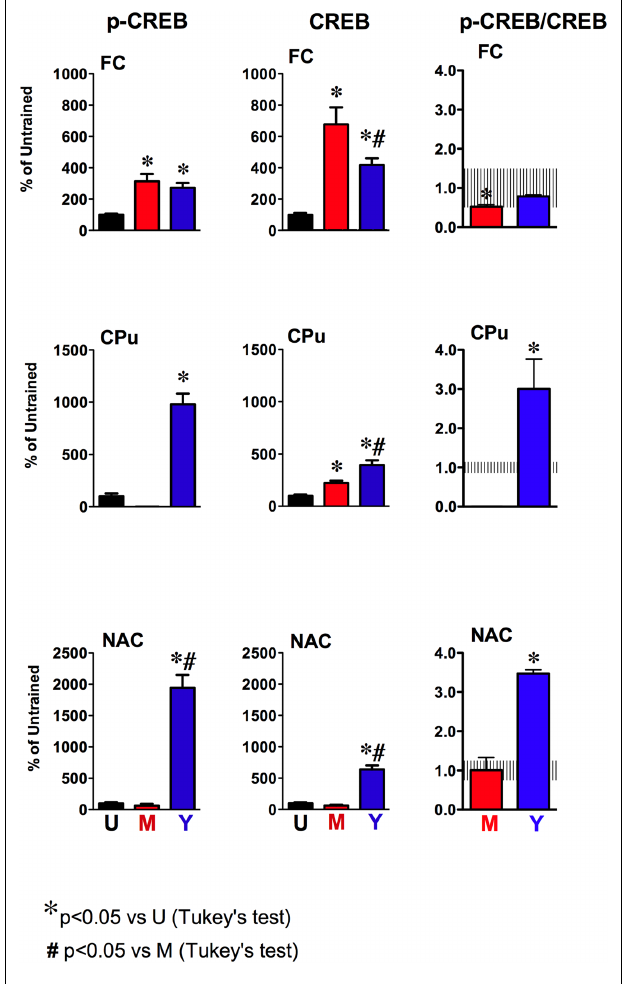
FIGURE 4 | Quantification of p-CREB and CREB levels and p-CREB/CREB ratios in the frontal cortex (FC) Caudate–putamen (CPu) and nucleus accumbens (NAC) of untrained (U), master (M), and yoked (Y) rats. Data are expressed as the percentage of protein level in untrained control rats. Histograms represent mean ± SEM of six to seven rats per group.The shaded areas represent the mean ± SD of p-CREB/CREB ratios for untrained control rats. * P < 0.05 vs. untrained (U); # P < 0.05 vs. master (M);Tukey’s test.